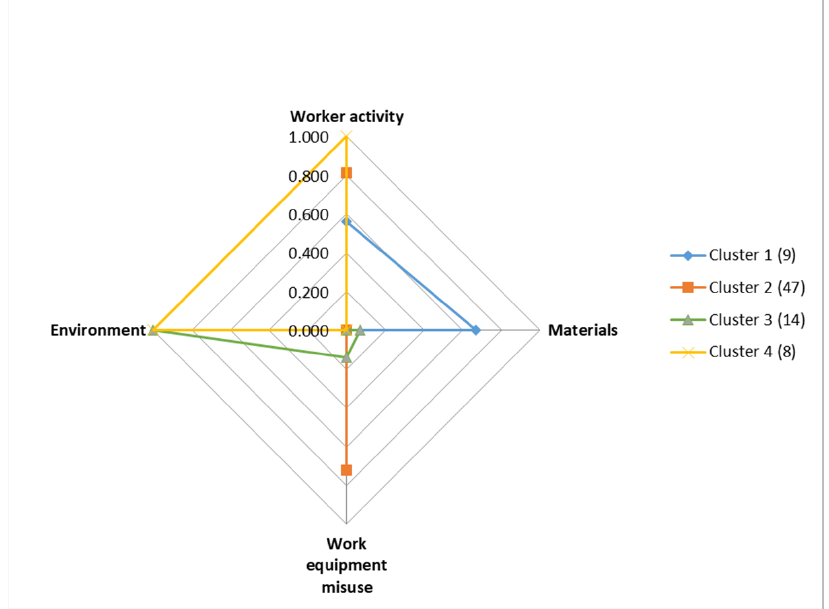
Figure 3. Result of the four-cluster solution.